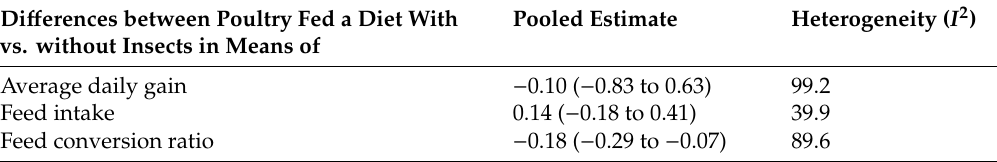
Pooled Estimate